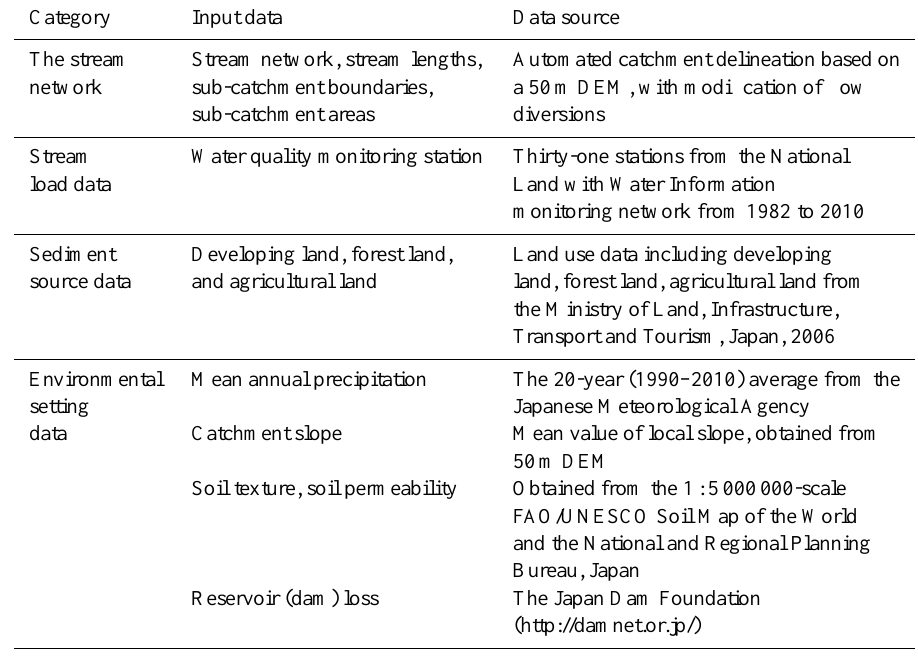
Table 1. Summary of input data and calibration parameters. References to data sources are in the main